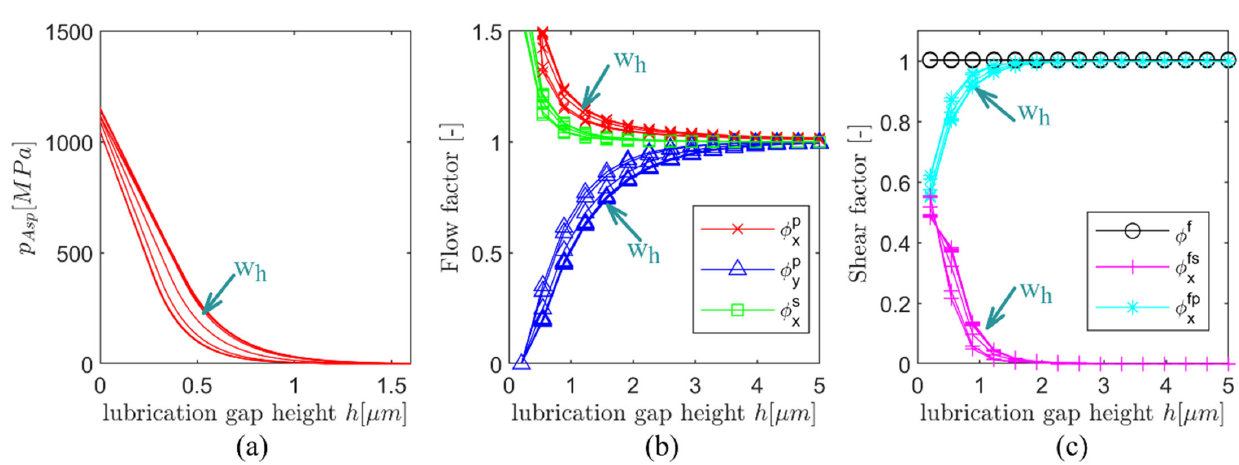
Figure 4. Results of the wear dependent micro model ( a ) asperity contact pressure, ( b ) flow factors, ( c ) shear factors.